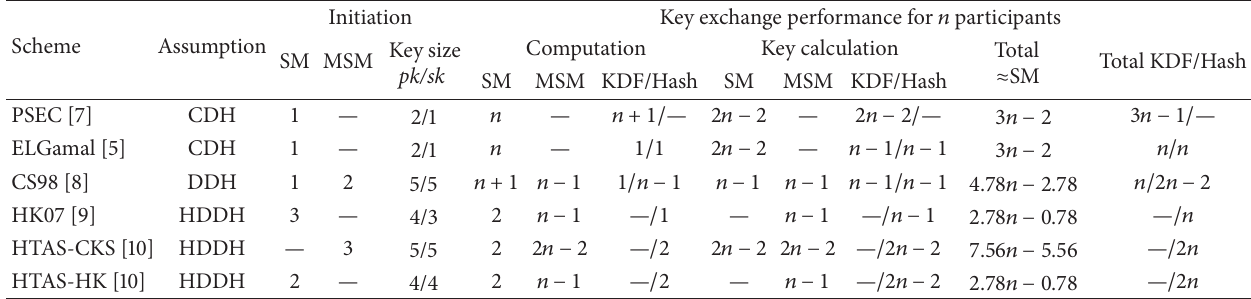
Table 1: Efficiency comparison of GAKE construction from different 𝑚 KEMs.